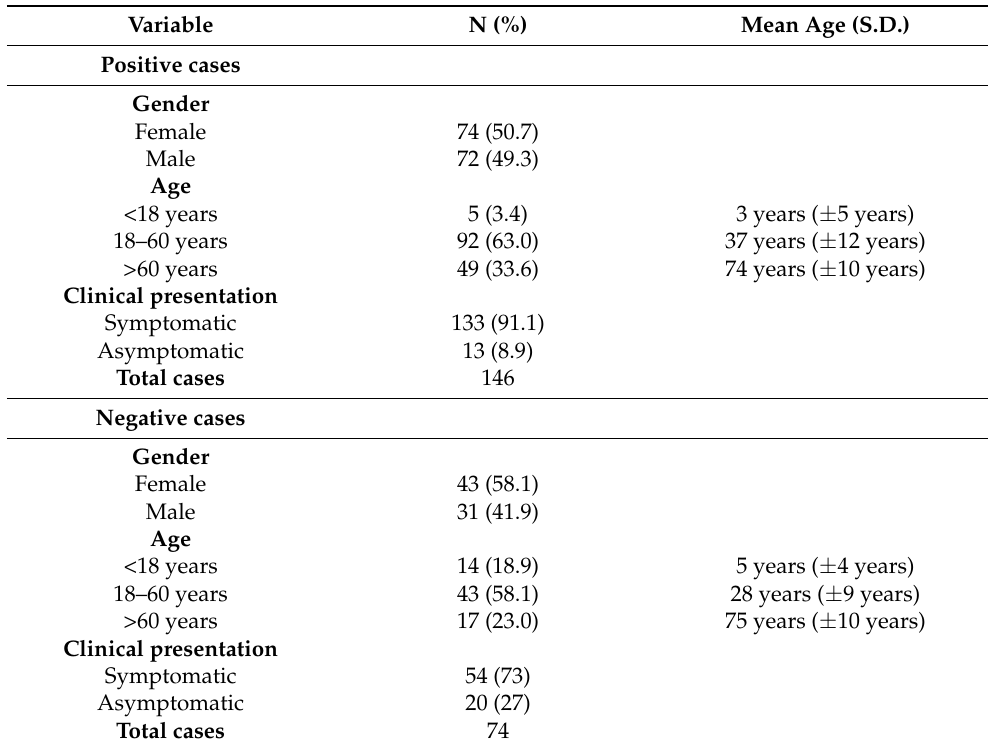
Table 2. Demographic characteristics of the analyzed